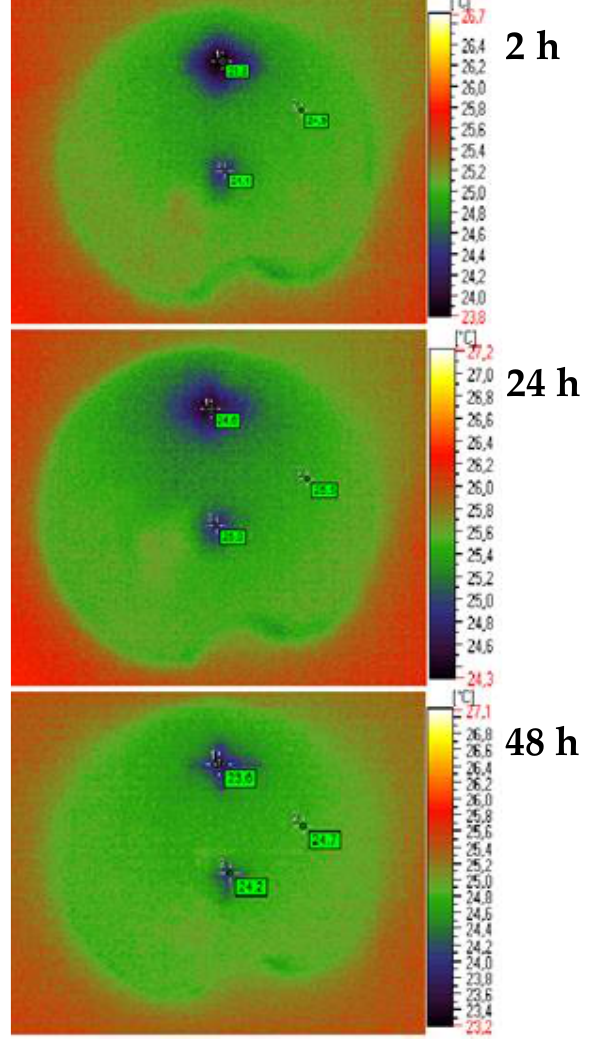
Figure 1. Infrared image of apple samples contaminated with the mixture P. expansum and B. cinerea , obtained with a VIGOcam V60 camera.